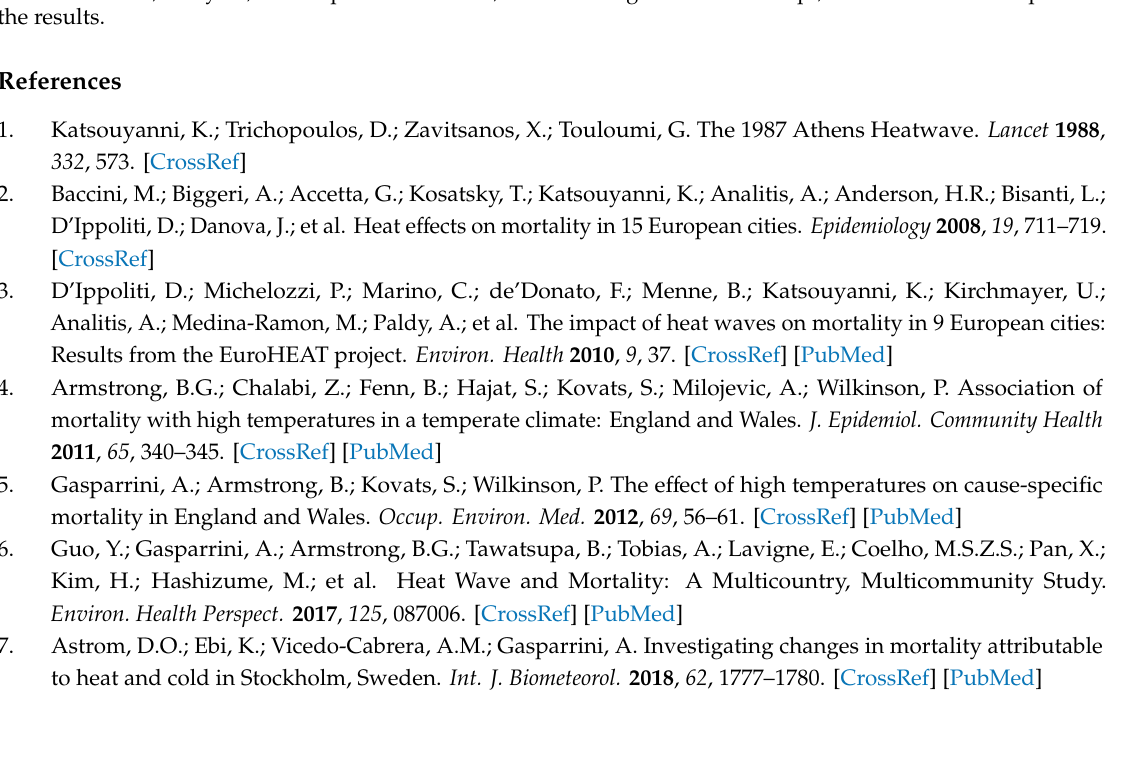
Figure S1: Temperature-mortality association by sector, using the E-OBS data, Figure S2: % increase in total mortality, all ages, per 1 ◦ C increase in maximum temperature in each municipality, using EOBS data and threshold of each sector, Figure S3: % increase in total mortality among elderly (75 + ) per 1 ◦ C increase in maximum temperature in each municipality, using EOBS data and threshold of each sector, Figure S4: % increase in cardiovascular mortality, all ages, per 1 ◦ C increase in maximum temperature in each municipality, using EOBS data and threshold of each sector, Figure S5: % increase in cardiovascular mortality among elderly (75 + ) per 1 ◦ C increase in maximum temperature in each municipality, using EOBS data and threshold of each sector, Figure S6: % increase in respiratory mortality, all ages, per 1 ◦ C increase in maximum temperature in each municipality, using EOBS data and threshold of each sector, Figure S7: % increase in respiratory mortality among elderly (75 + ) per 1 ◦ C increase in maximum temperature in each municipality, using EOBS data and threshold of each